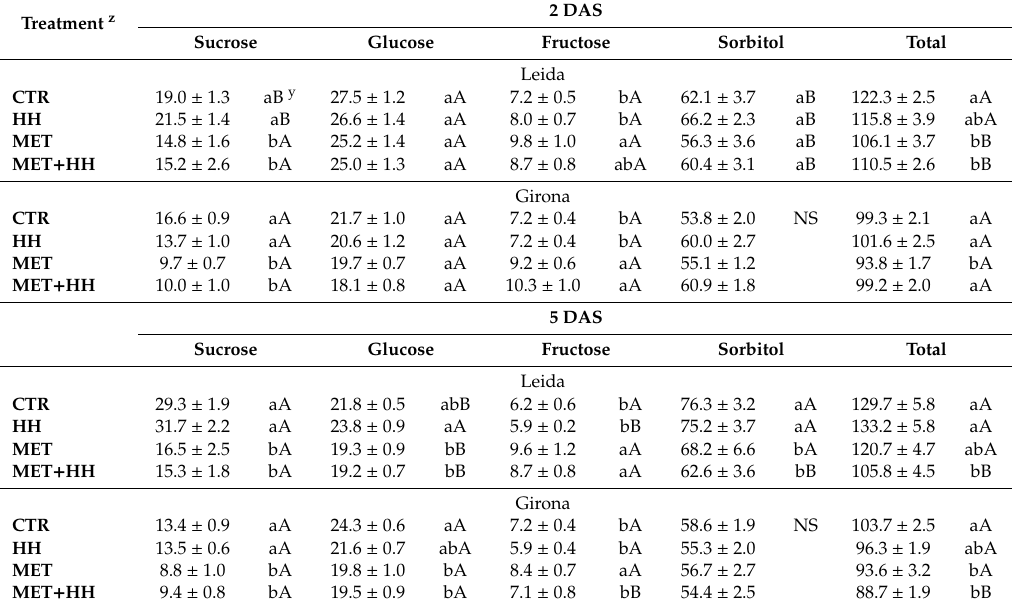
Table 3. The sucrose, glucose, fructose, sorbitol, and total sugar concentration in the leaf (mg g − 1 DW) evaluated 2, 5, and 10 days after spraying (DAS) in the trials with ‘Golden Reinders’ apple in Lleida and Girona,